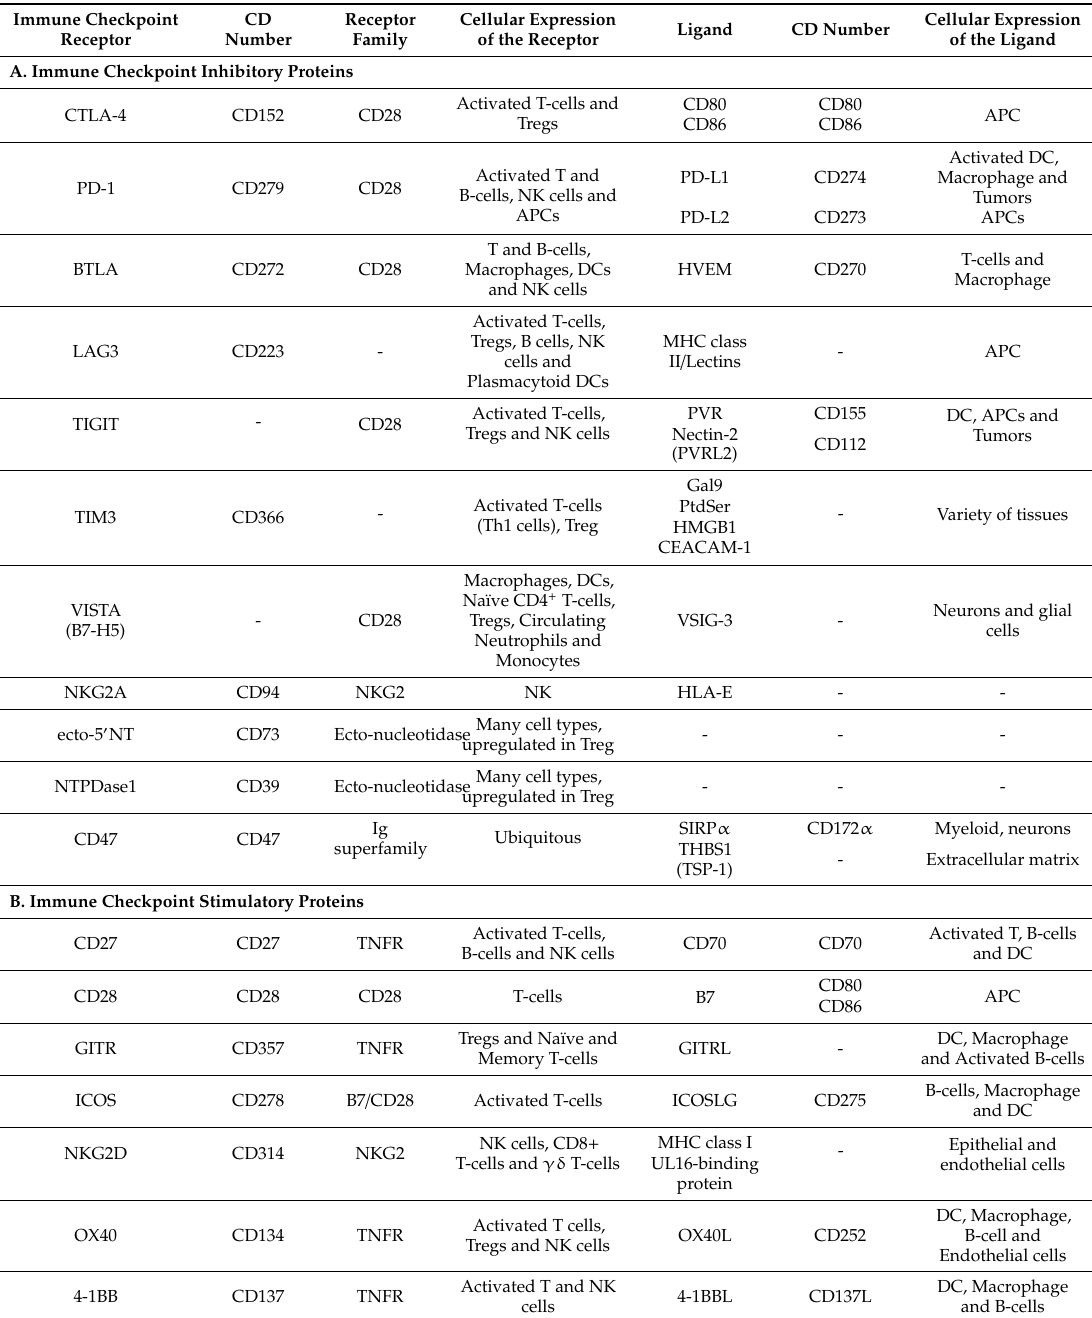
Table 4. Major immune checkpoint inhibitory and stimulatory